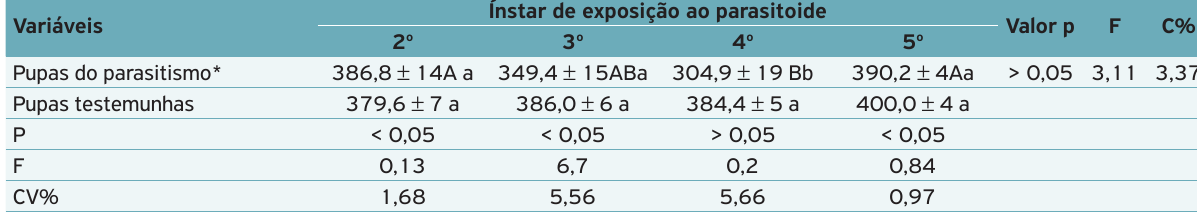
Tabela 1. Peso (mg) de pupas de Ascia monuste orseis oriundas do insucesso do parasitismo por Cotesia glomerata nos diferentes